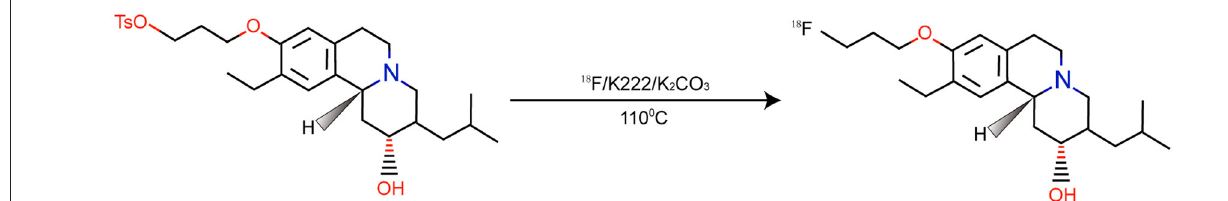
FIGURE 1 | Synthesis route of 18 F-FP-( + )-DTBZ.